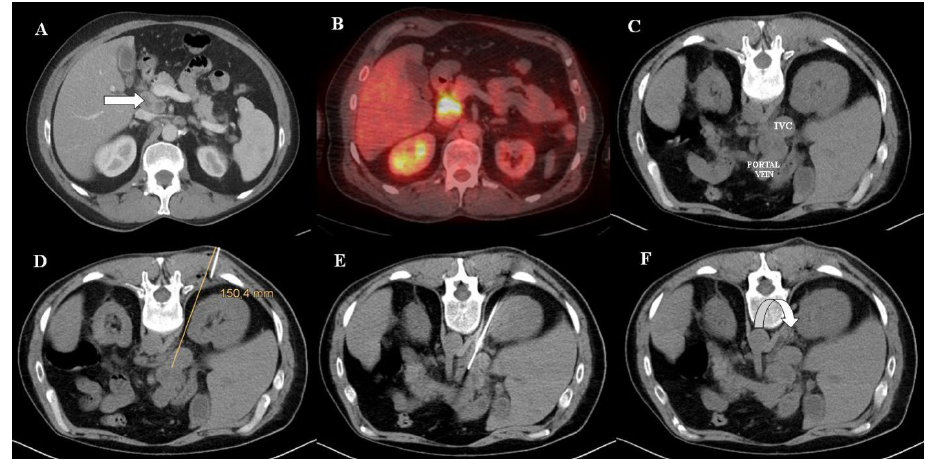
Fig. 1. The biopsy in the retroperitoneum using transcaval approach. Affected lymphatic nodes between large vessels in transversal plane (A, arrow) on contrast medium enhanced CT and si- multaneously proven viable mass on PET/CT (B). Preprocedural CT examination confirms the lymphnode localization between inferior vena cava and portal vein, patient in prone position (C). The placement of the local anesthesia needle and planning the track (D) and insertion of the biopsy needle (E, patient in prone position). The control CT examination revealed only minor perinodal and perivascular changes (F, curved arrow). The histological result was Hodgkin lymphoma, sub- type nodular